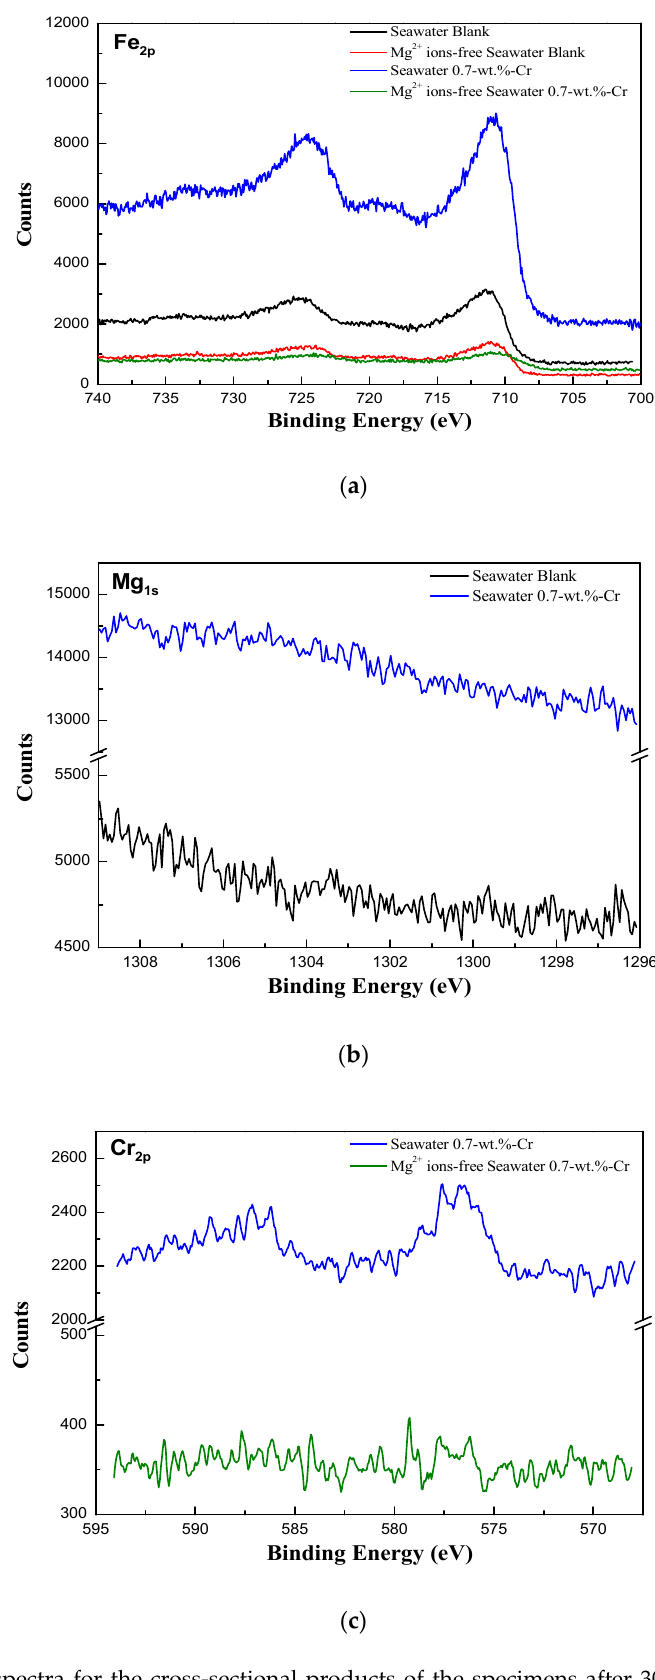
Figure 8. XPS spectra for the cross-sectional products of the specimens after 30 days immersion according to seawater conditions and alloying elements: ( a ) Fe, ( b ) Mg and ( c ) Cr.